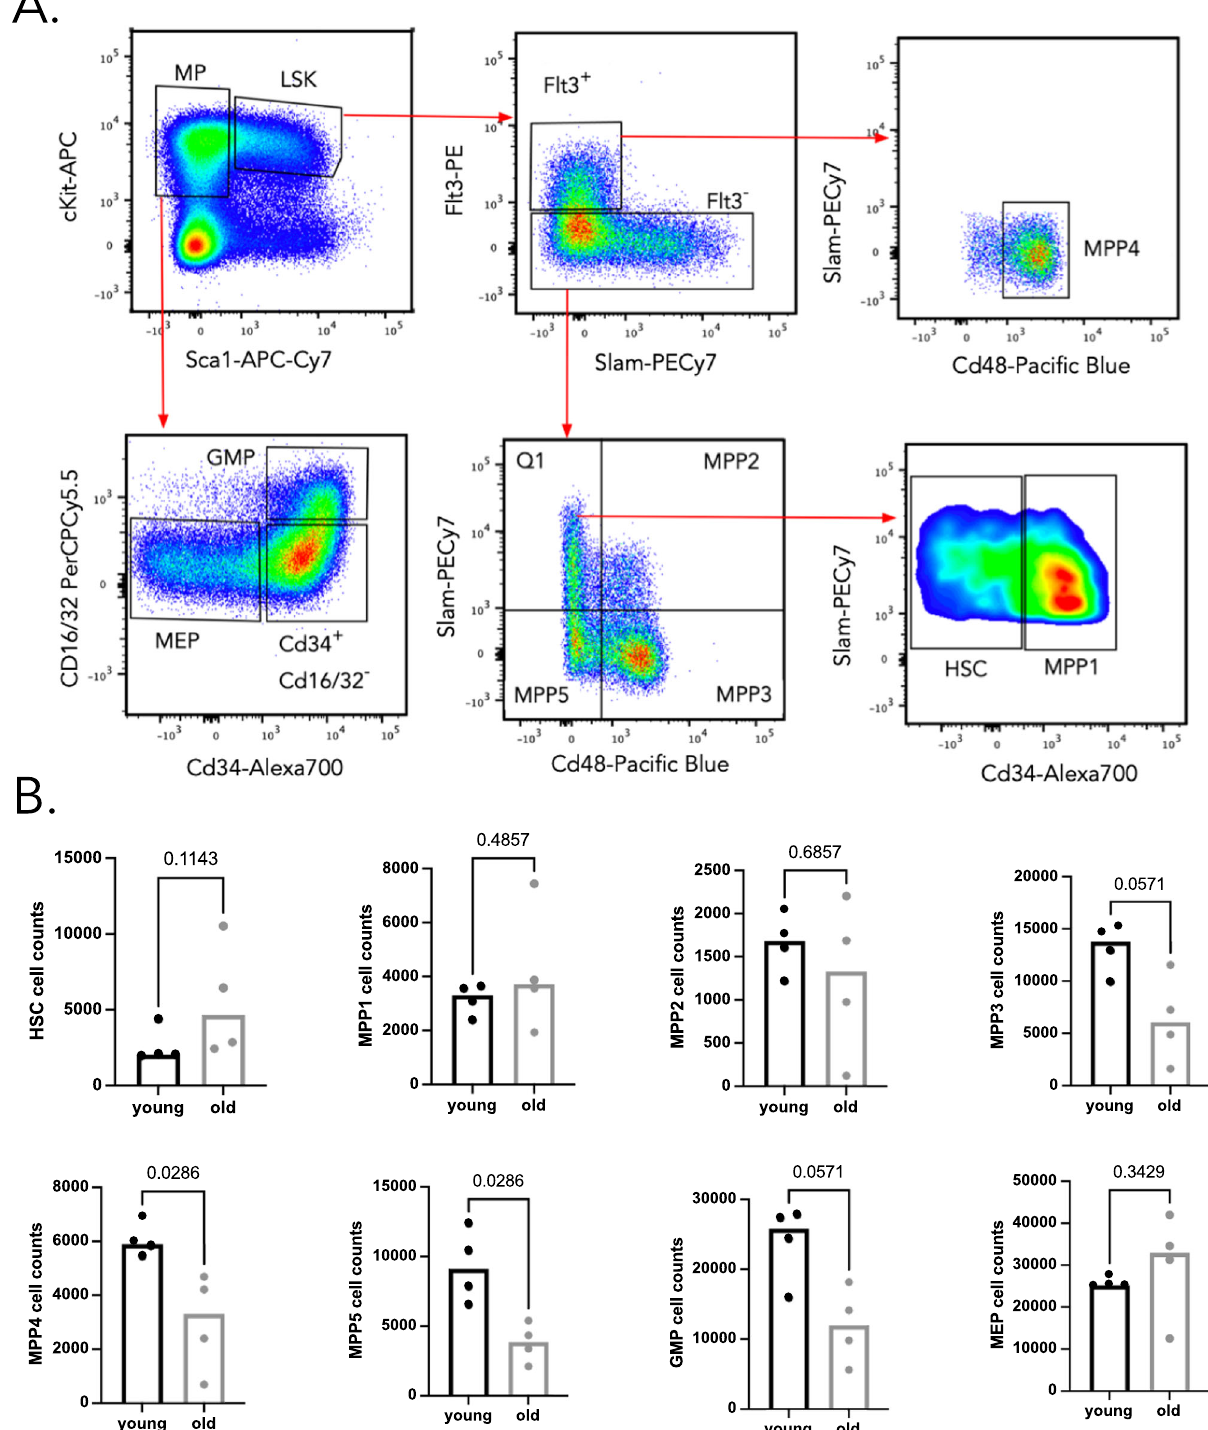
Fig. 7 | Flow cytometry pro fi ling of hematopoietic progenitors and mature myeloidsubsetsinyoungandoldmice.A Gatingstrategytoidentifythedifferent HSPC and MP subsets. B Quanti fi cation of HSPCs, MP, and M subset counts between young (6.5 months) and old (19 months) male DRAG mice. Each point represents one mouse and n =4 mice. The Y -axis represents the number of cells